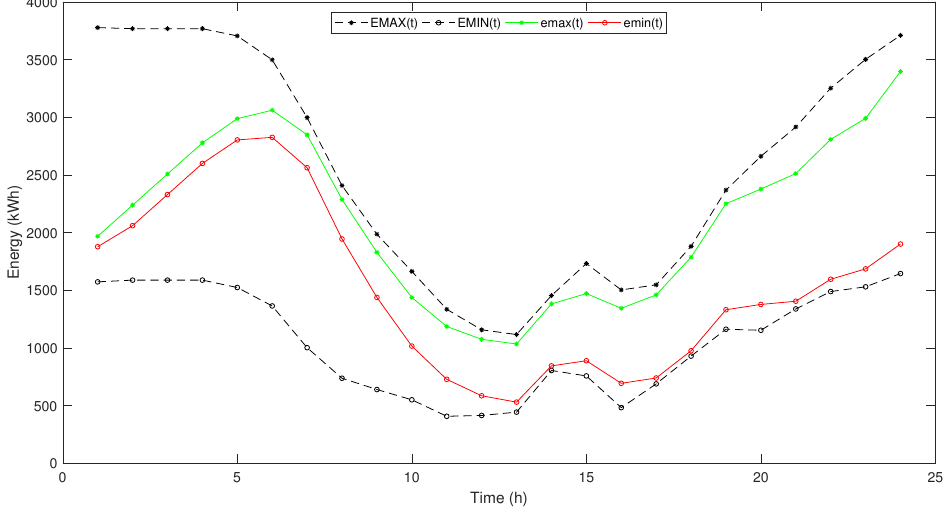
Figure 4. Evolution of bounding variables e min